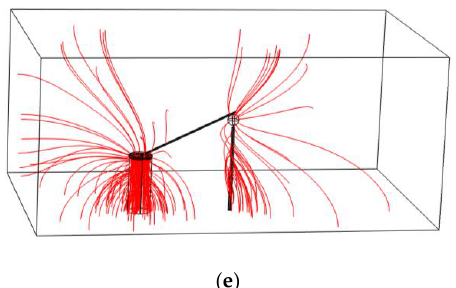
Figure 3. ( a ) Mesh of the entire domain of the resistive divider. ( b ) Mesh in the surface of the divider. ( c ) Streamline plot of the electric field lines around the divider within the analyzed domain. ( d ) Mesh of the entire domain, including the AC generator. ( e ) Streamline plot of the electric field lines around the divider and the generator.